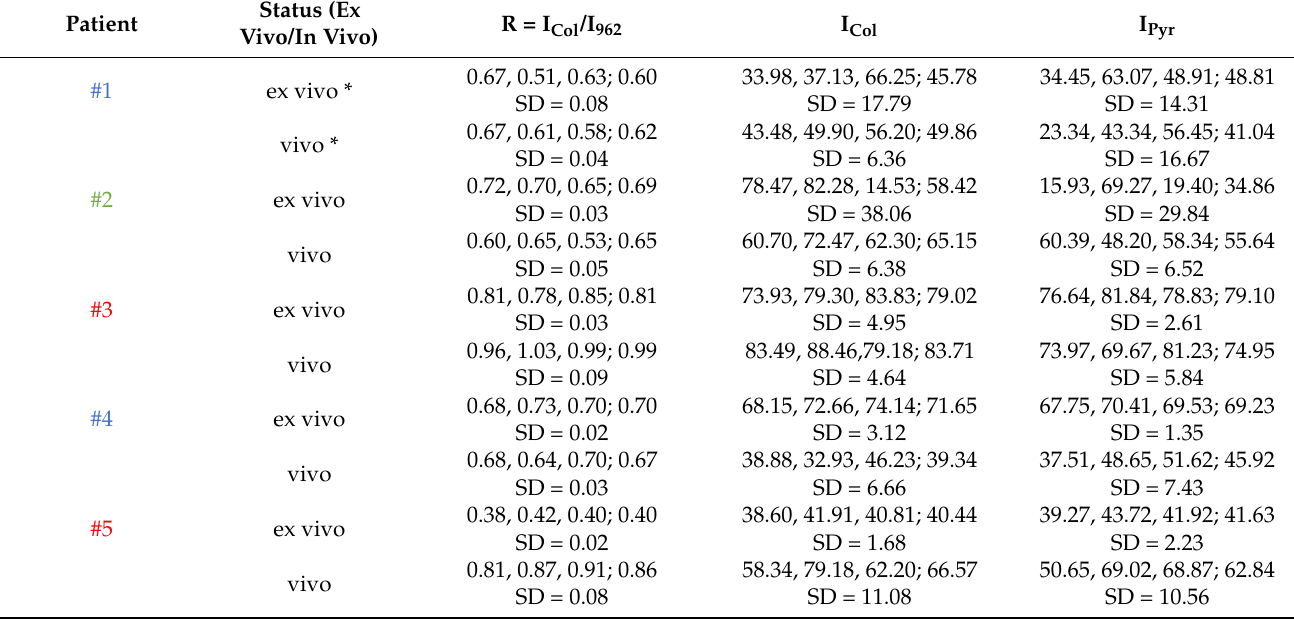
Table 3. Summarized Raman results. Ratio (R) of normalized Raman peaks intensities, peaks intensities (I) according to Raman shift. Summarized results: normalized, average values (three points for in vivo */ex vivo *, data acquisition), standard deviation SD included. Legend: